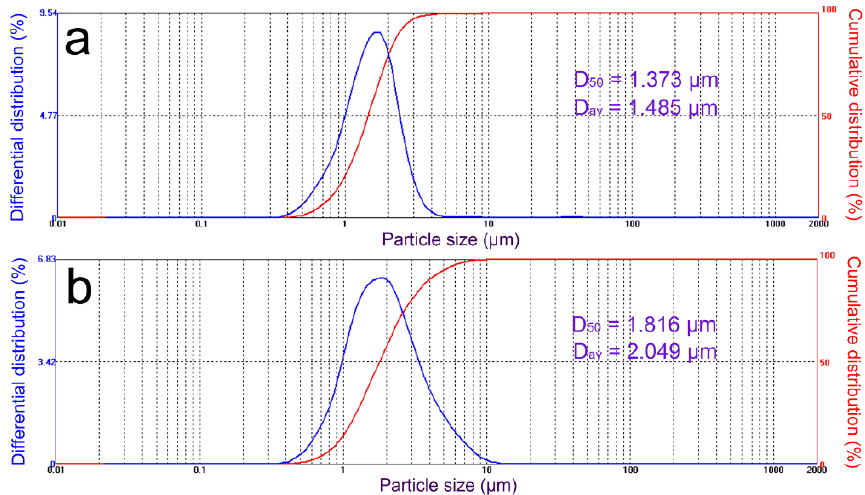
Figure 4. Particle size distribution of natural ATP ( a ) and CM-ATP ( b ). D 50 and D av are the median particle size and average particle size, respectively.